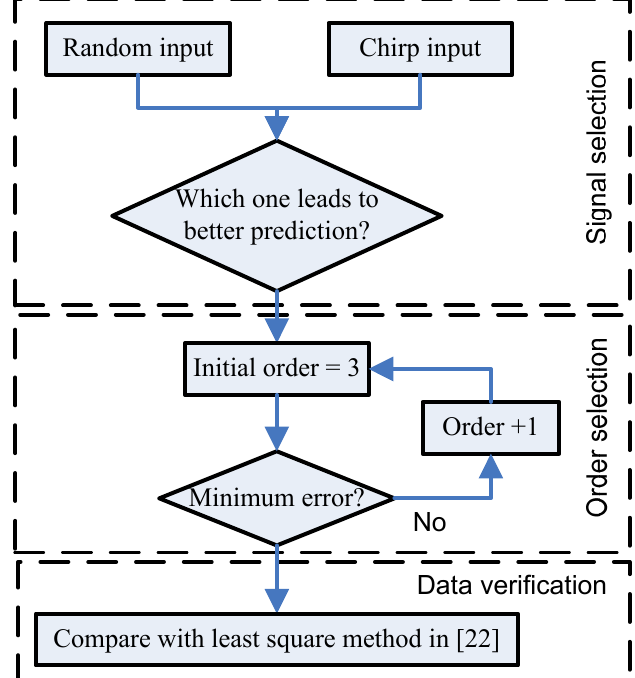
Figure 3. Flow chart of black box system